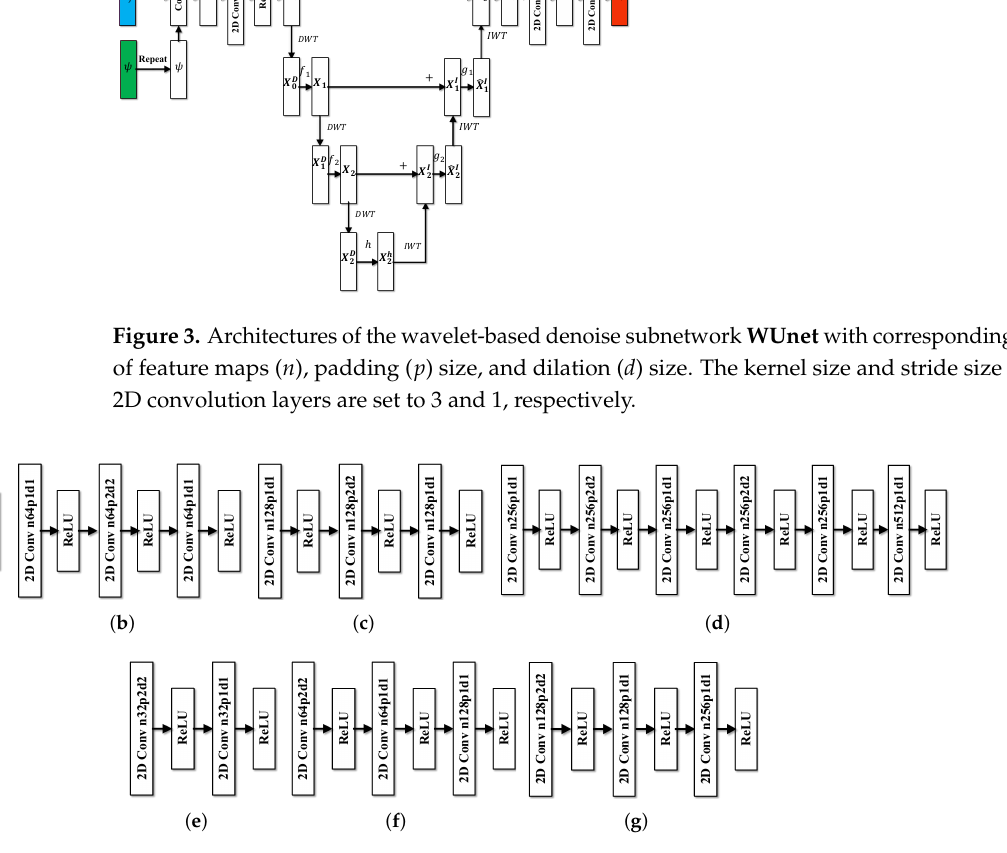
Figure 4. Architectures of the f 0 , f 1 , f 2 , h , g 0 , g 1 , and g 2 used in WUnet with corresponding number of feature maps ( n ), padding ( p ) size, and dilation ( d ) size. The kernel size and stride size of all the 2D convolution layers are set to 3 and 1, respectively. ( a ) f 0 . ( b ) f 1 . ( c ) f 2 . ( d ) h . ( e ) g 0 . ( f ) g 1 . ( g ) g 2 .